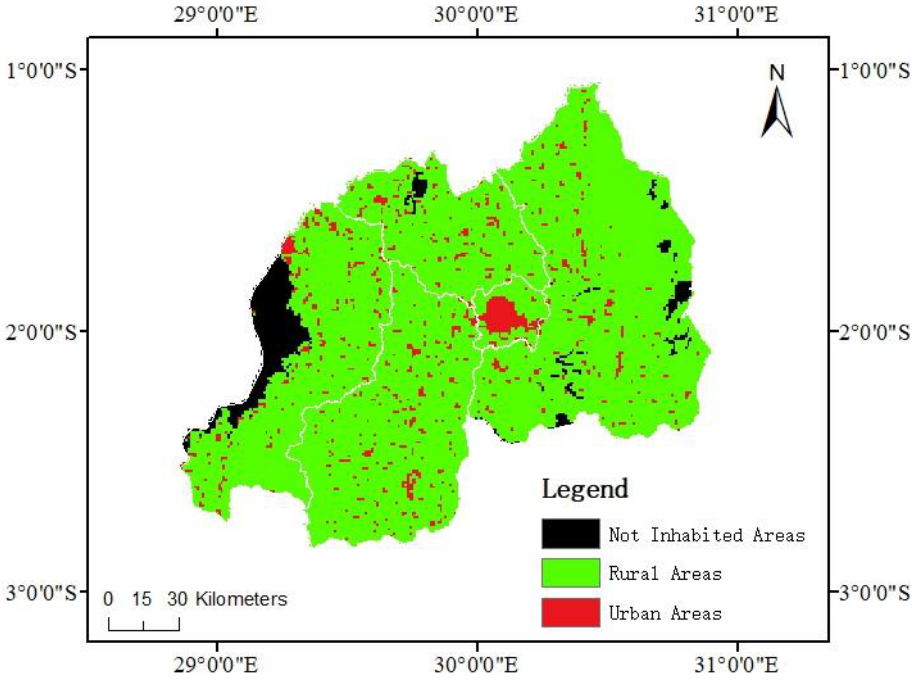
Figure 4. The urban, rural, and not inhabited areas in Rwanda.